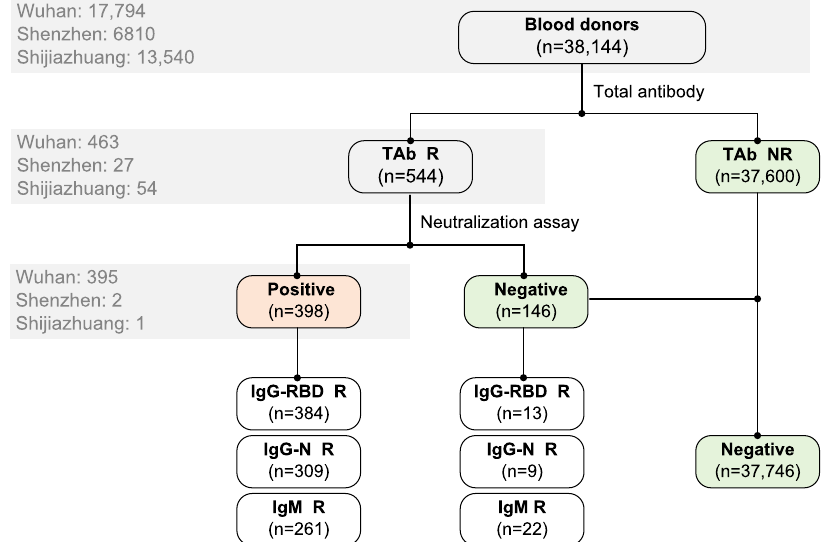
Fig. 1 Flowchart of screening and con fi rmatory procedure. A total of 38,144 blood donations were tested for SARS-CoV-2 total antibody (TAb). Those reactive were further con fi rmed by neutralization assay and tested for IgG antibody against receptor-binding domain (RBD) of the spike protein and nucleoprotein of SARS-CoV-2 (IgG-RBD and IgG-N), and IgM antibody against SARS-CoV-2. Three-hundred ninety-eight donors were fi nally con fi rmed for SARS-CoV-2 seropositivity. The numbers of donations tested for speci fi c antibodies in three cities are shown in the gray box. The crude seroprevalence of antibodies to SARS-CoV-2 among blood donors was calculated by the number of con fi rmed positive donors divided by the total number of tested donors: 2.22% (395/17,794, 95% CI: 2.01 – 2.45%) in Wuhan, 0.029% (2/6810, 95% CI: 0.0081 – 0.11%) in Shenzhen, and 0.0074% (1/13,540, 95% CI: 0.0013 – 0.042%) in Shijiazhuang, respectively. R, reactive; NR, nonreactive; IgG-RBD, IgG antibody against receptor-binding domain (RBD) of the spike protein of SARS-CoV-2; IgG-N, IgG antibody against nucleoprotein of